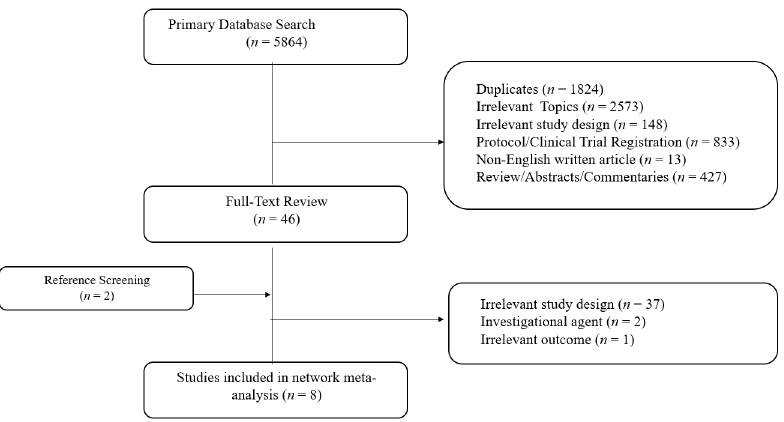
Figure 1. PRISMA